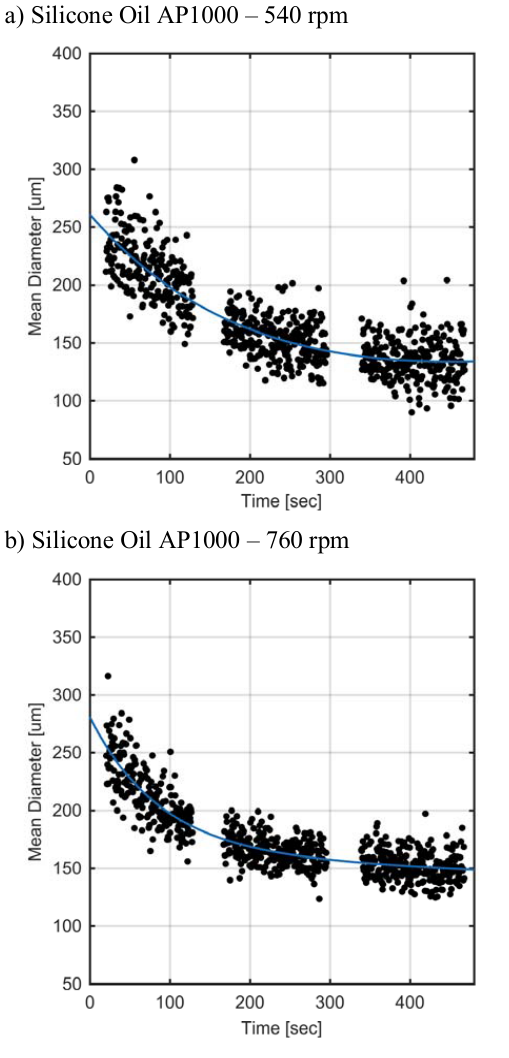
Fig. 3. Mean Particle Diameter time dependence of Silicon Oil AP1000 for a) 540rpm, and b) 760 rpm stirrer speed.